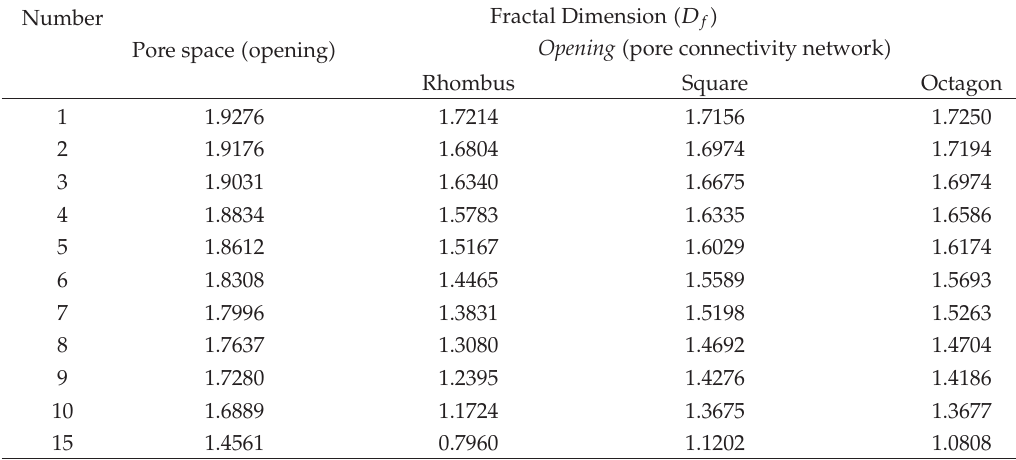
Table 1: Fractal dimension estimation on pore connectivity networks and pore space by using box-counting